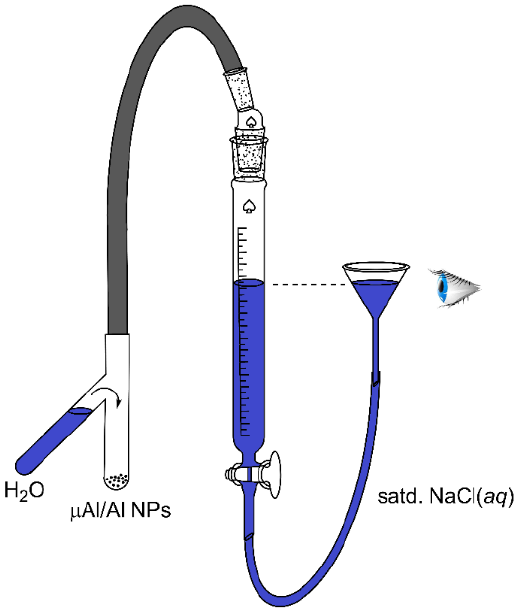
Figure 1. Hydrolysis activation and H 2 collection apparatus.